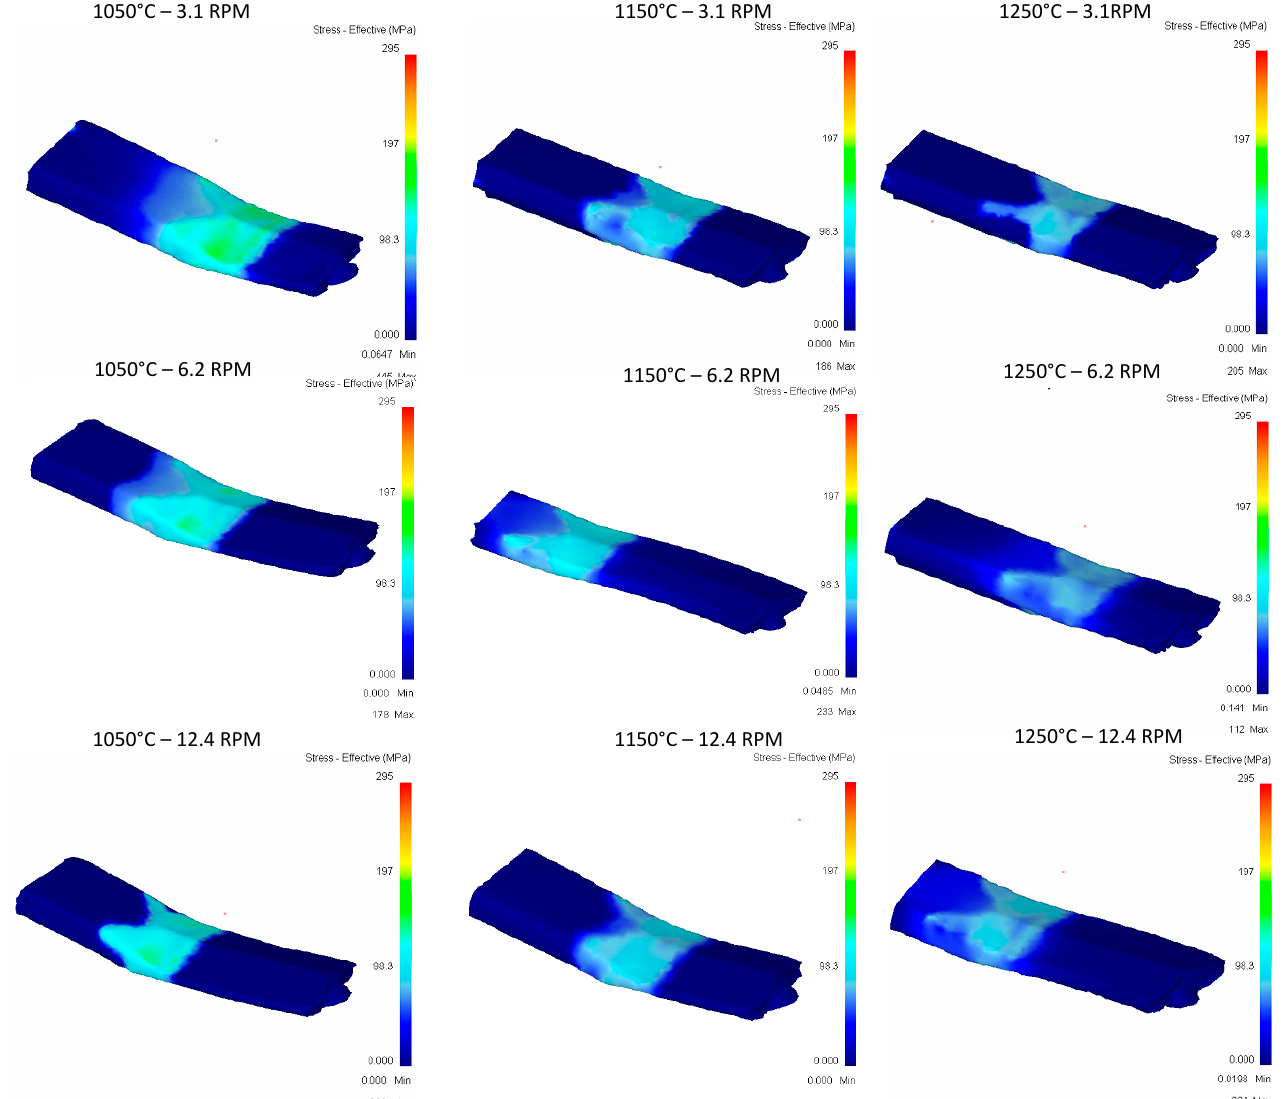
Figure 13. Effective stress in the top Rail after second pass.